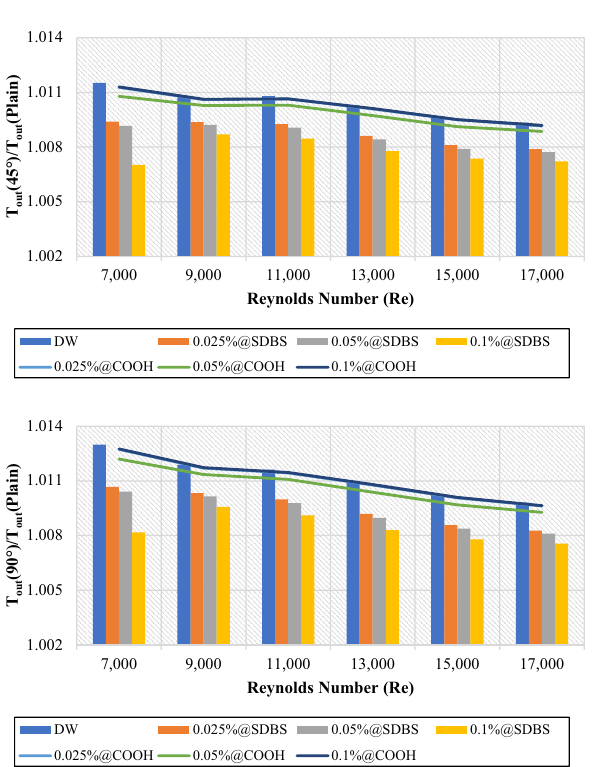
Figure 9. Hydrothermal performance of nanofluids to base fluid versus Reynolds numbers for 45° and 90° tubes.